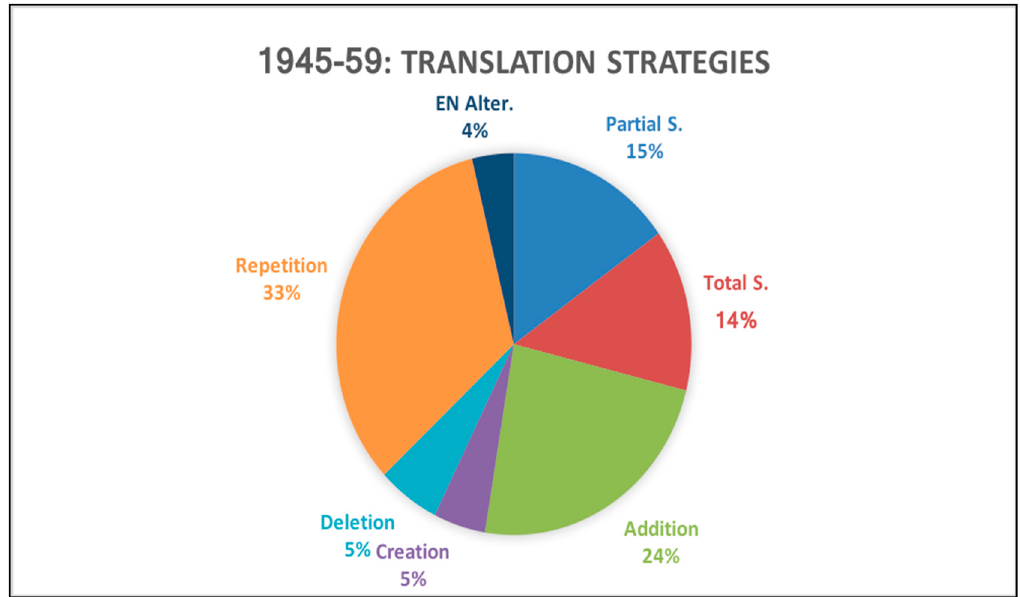
Chart 2. Graph showing the distribution of translation strategies for the 1945–59 timeframe.